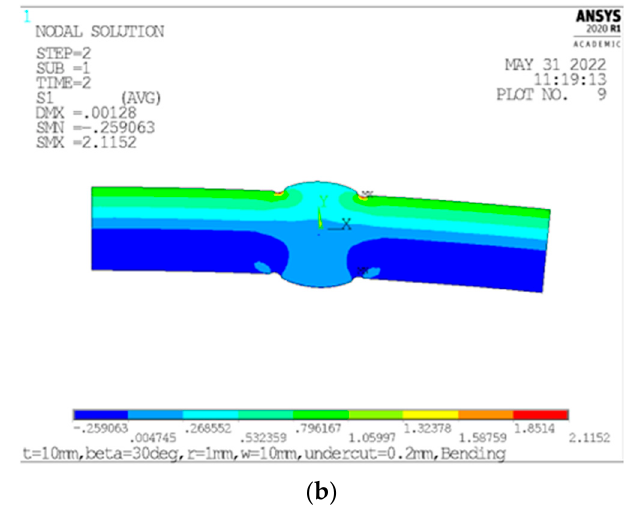
Figure 4. Nodal averaged solution for maximum principal stress for the load case: ( a ) tension; ( b ) bending.